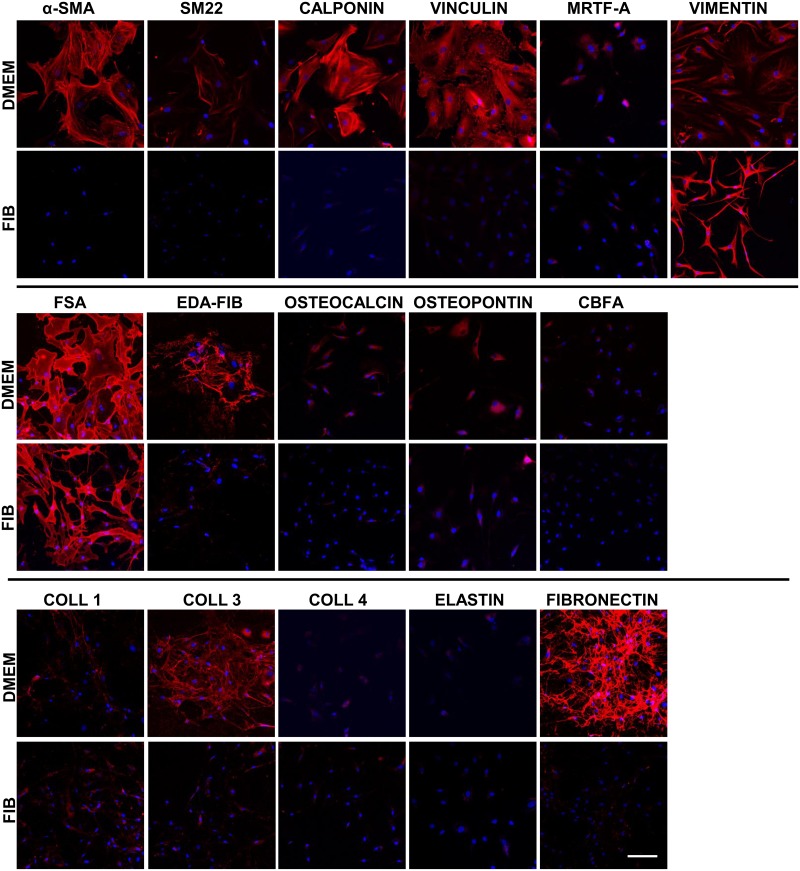
Immunostaining of VICs in DMEM and FIB media.
EDA-FIB, EDA-splice variant of fibronectin; coll, collagen. Data labelled as FIB is from VICs that were switched to fibroblast media for 2 weeks prior to analysis. Scale bar represents 50μm.